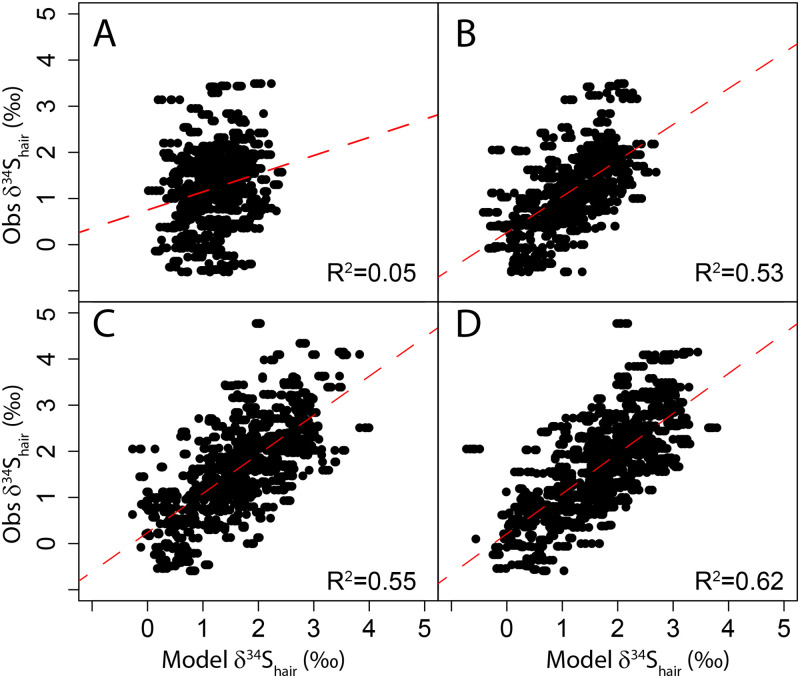
Observed δ34Shair against modeled δ34Shair.A. Dietary and demographic data regression model including seafood, wine, and water consumption; B. Dietary, demographic and geographic data regression model including longitude, seafood, wine, and water consumption; C. Environmental variables data regression model including sea salt aerosol deposition and soil pH; D. Dietary, demographic, geographic and environmental variable regression model including sea salt aerosol, soil pH, precipitation and seafood consumption. The red dashed line is the best fit linear model.